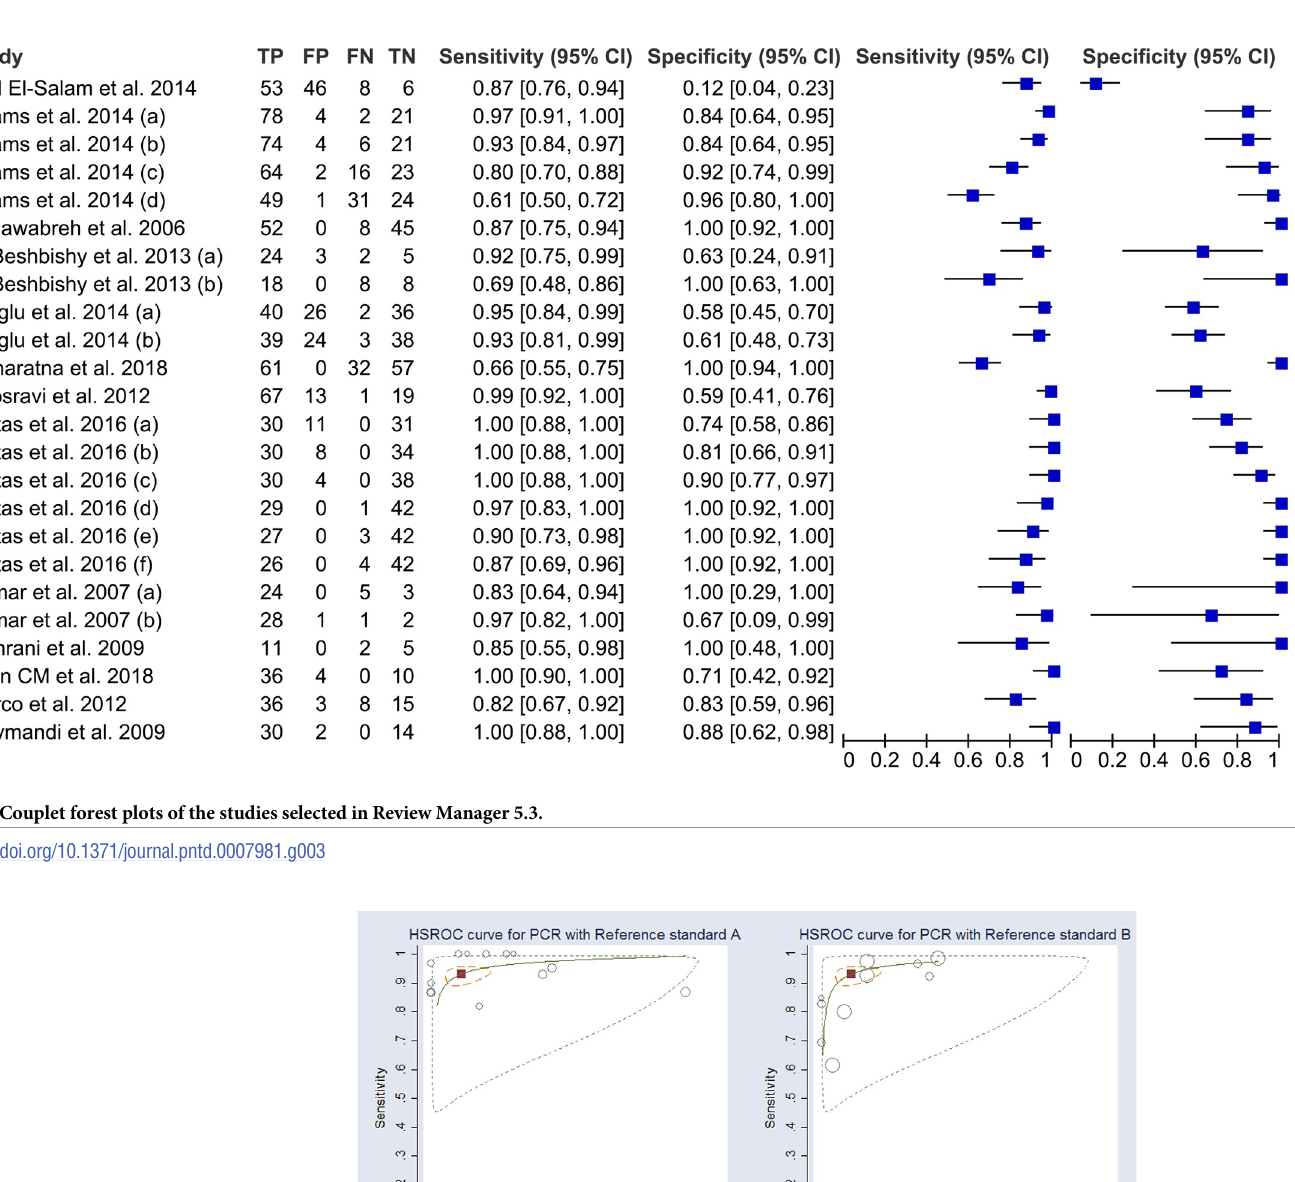
Fig 4. HSROC curve for PCR. A. In smear sample, reference standard A, case control and consecutive studies combined. Circles represent estimates of individual primary studies, and square indicates summary points of sensitivity and specificity. The circled region around the solid square represent the 95% CI region around the summary estimate. HSROC curve is obtained using command “metandiplot” in STATA version 14. B. In skin biopsies and aspirate samples, reference standard B and case control and consecutive studies combined. Circles represent estimates of individual primary studies, and square indicates summary points of sensitivity and specificity. The circled region around the solid square represent the 95% CI region around the summary estimate. HSROC curve is obtained using command “metandiplot” in STATA version 14.